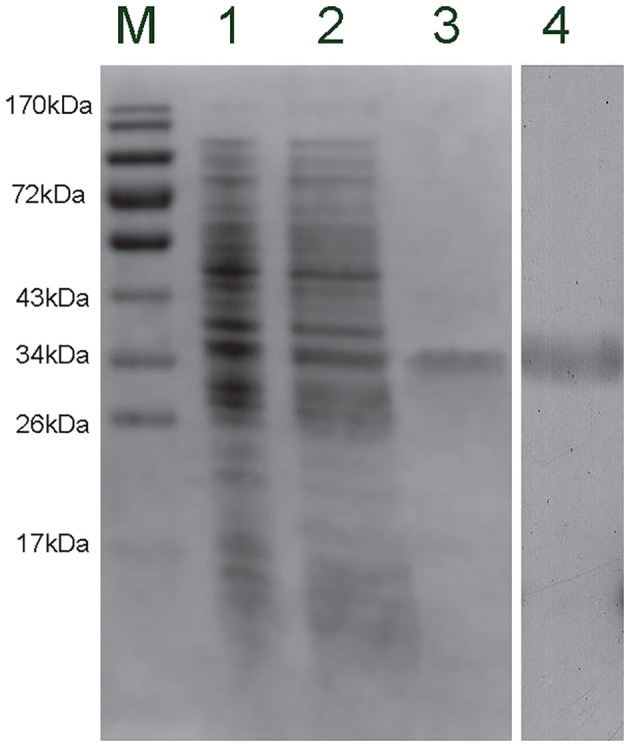
Sodium dodecyl sulfate–polyacrylamide gel electrophoresis (SDS-PAGE) and Western blot analysis of CgCD63H. Lane M, protein molecular standard; lane 1, negative control for CgCD63H (without induction); lane 2, induced rCgCD63H; lane 3, purified rCgCD63H; lane 4, Western blot using purified anti-CgCD63H based on the hemocytes lysate sample.